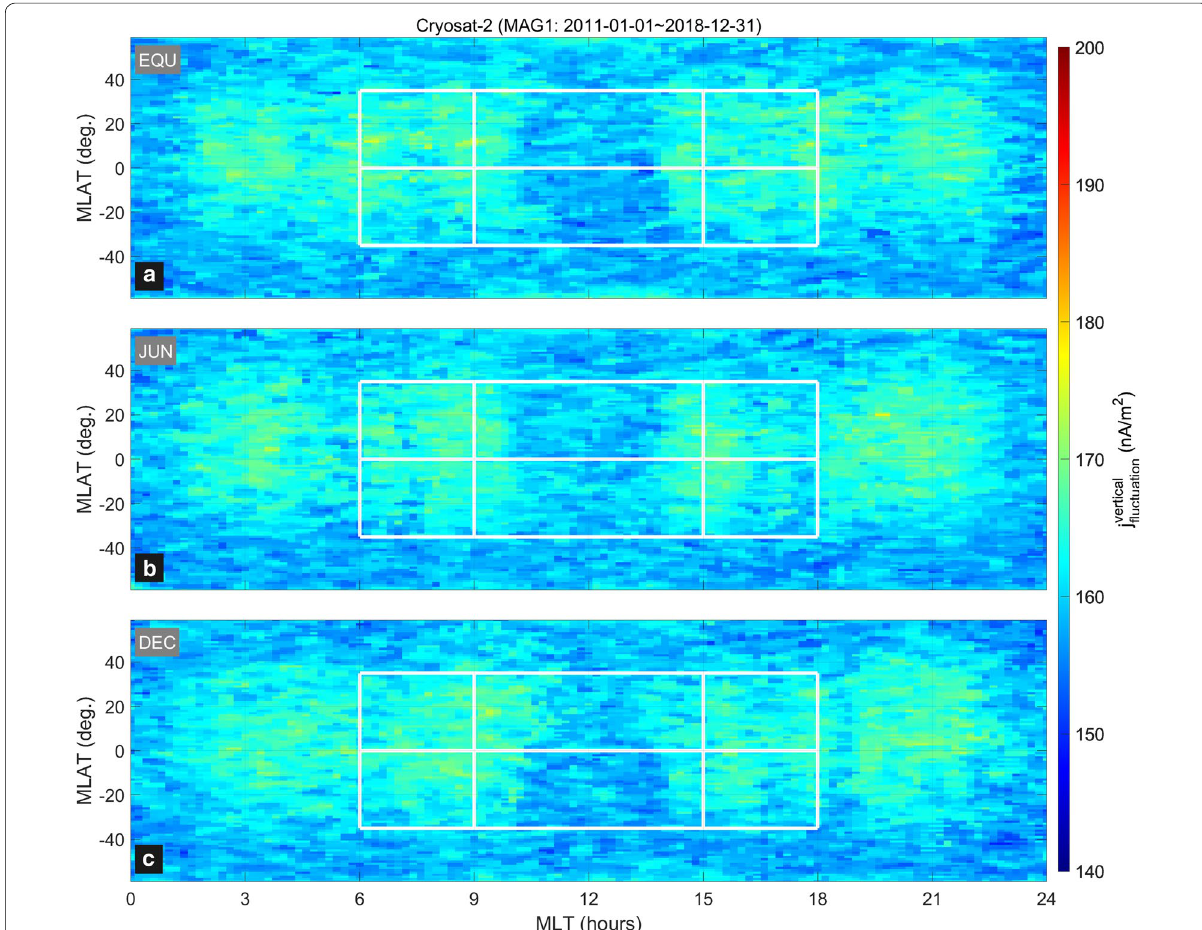
Fig. 10 The same as Fig. 2, but presenting fluctuation levels of vertical current density, which are calculated by absolute magnitude of the adjacent difference of the current density time